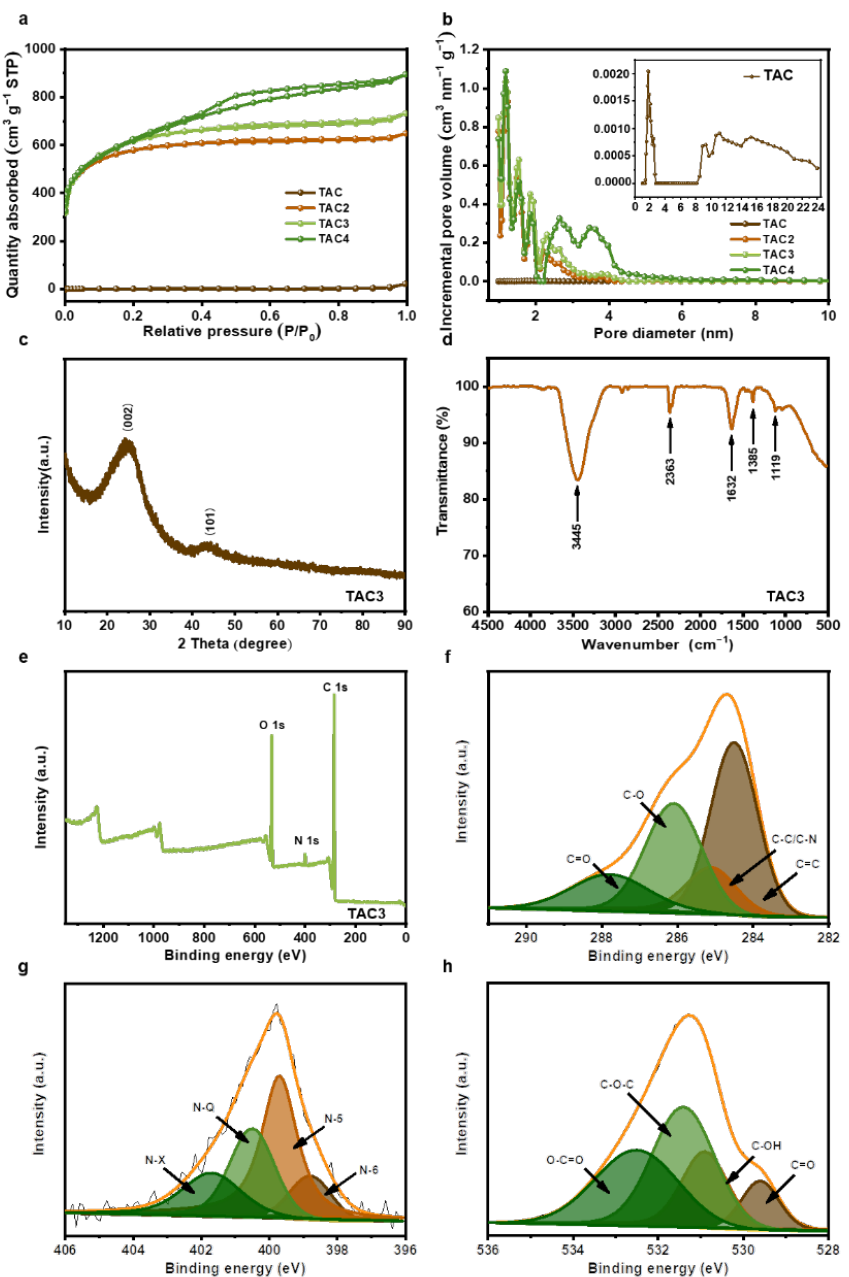
Figure 3. N 2 adsorption–desorption isotherms ( a ) and pore size distributions ( b ) of tea-waste-based activated carbons, XRD pattern ( c ), FT-IR analysis ( d ), XPS survey spectra ( e ), and high-resolution C